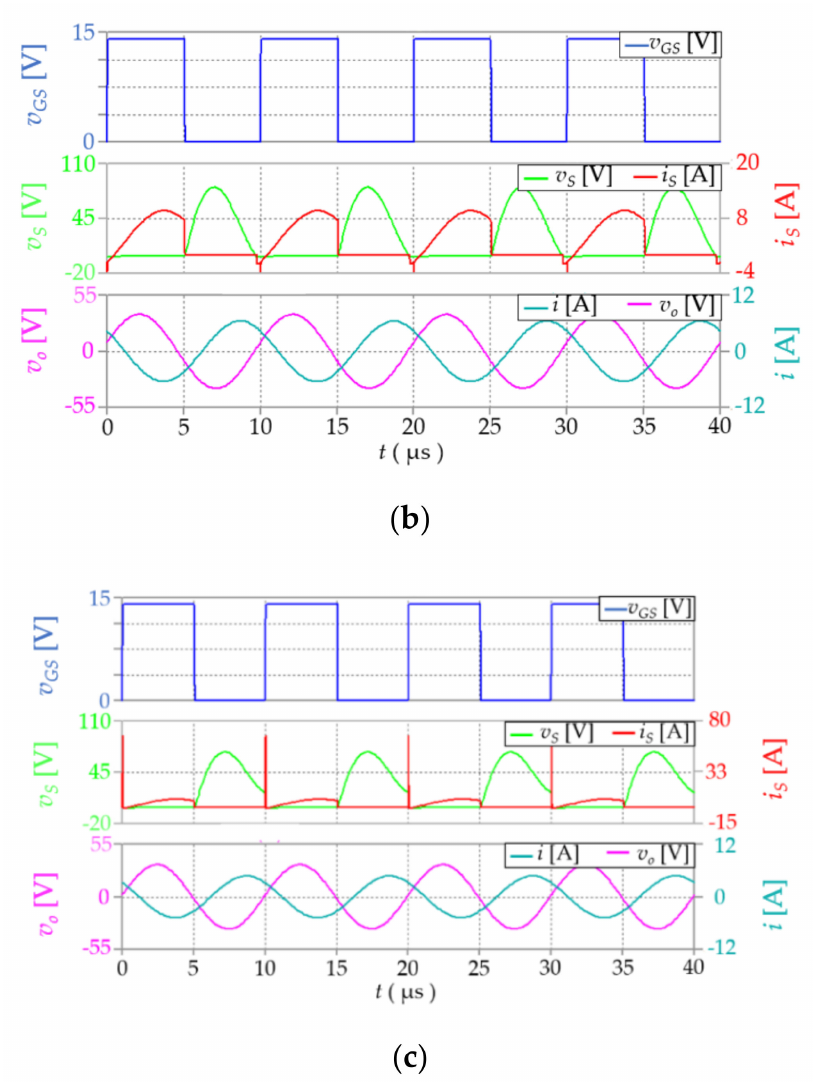
Figure 11. Simulated waveforms at several coupling capacitance C M values. ( a ) 25 pF. ( b ) 32 pF. ( c ) 45